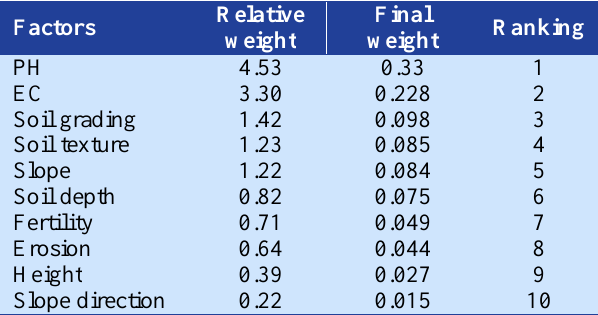
Table 1. Final weight of the factors studied